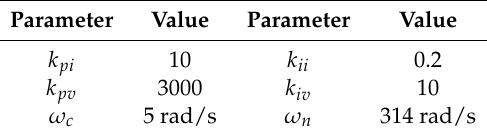
Table 3. Control